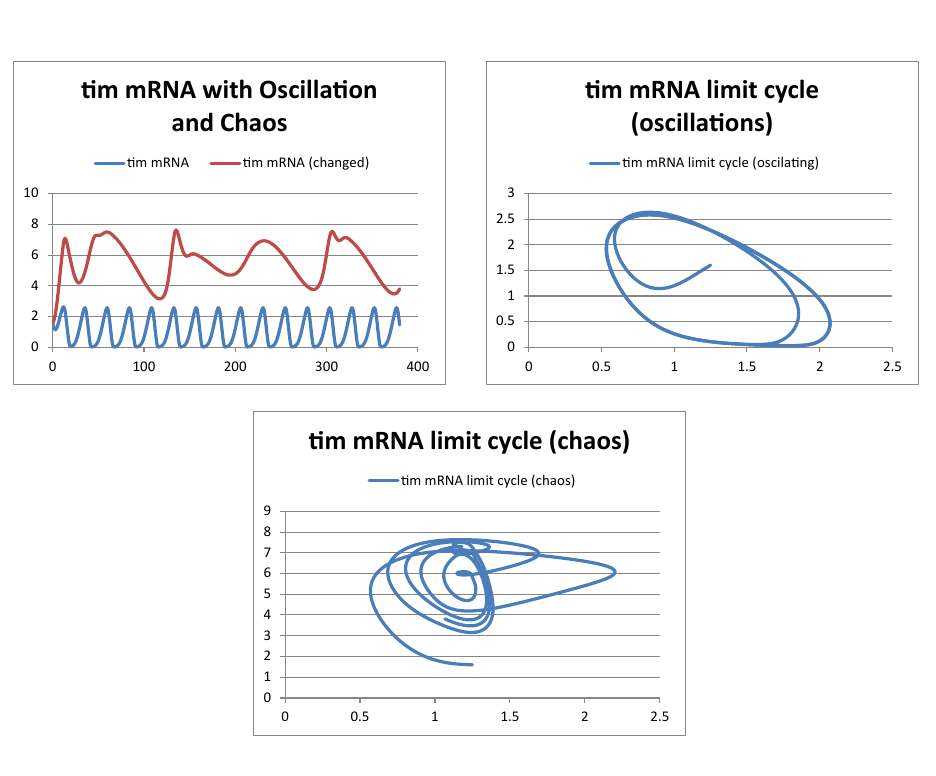
Figure C.2: The simulation result gained from the simulation description given in Listing